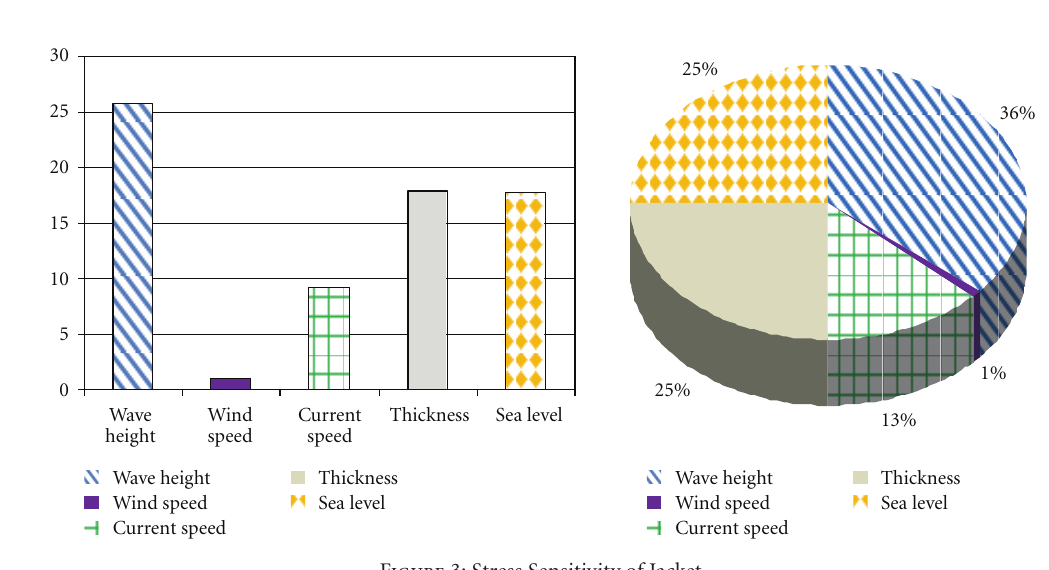
Figure 3: Stress Sensitivity of Jacket.